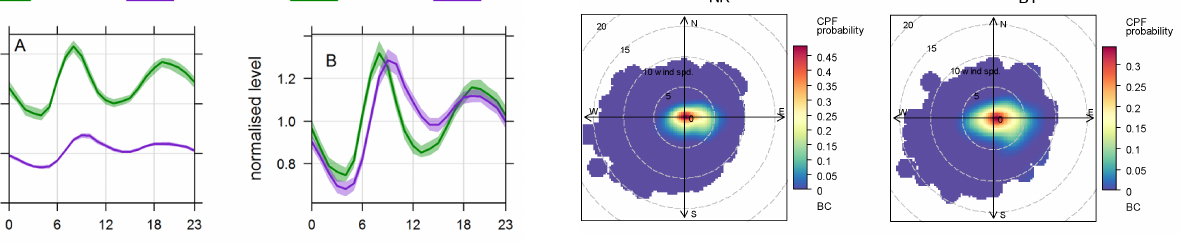
Figure 11. CPF analysis for BC concentrations at 880nm over the whole sampling period at NK and the BT tower. Note the NK con- centrations were determined with a 2W AE and the BT tower con- centrations with a 7W AE. Wind speed (wind spd) is in ms − 1